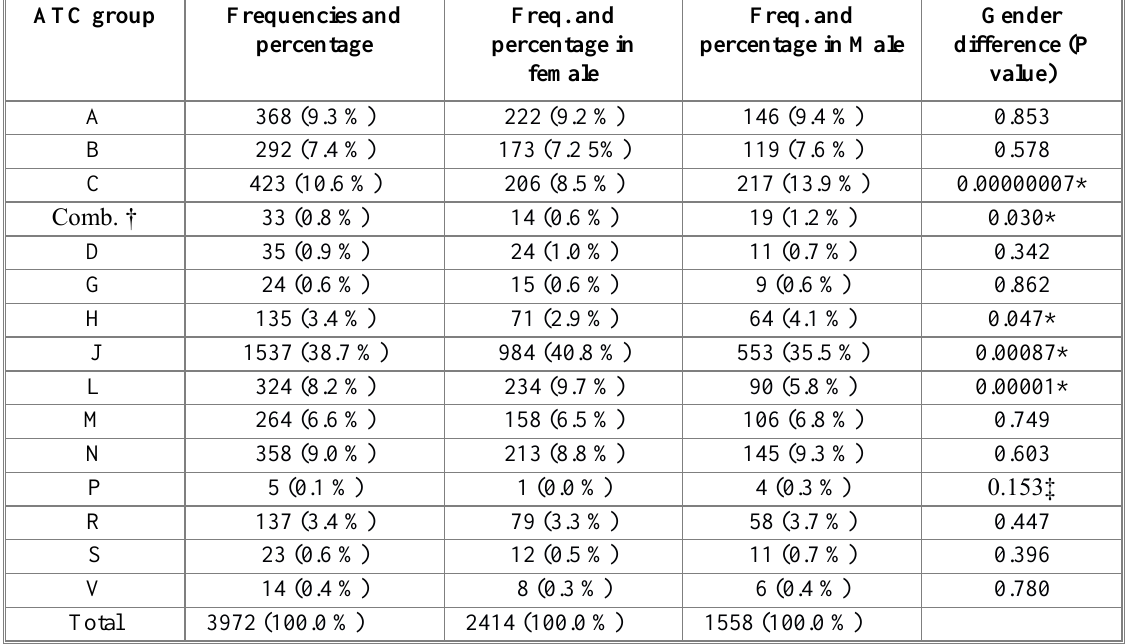
Table 3. Drug ATC group in both gender ATC group Frequencies and